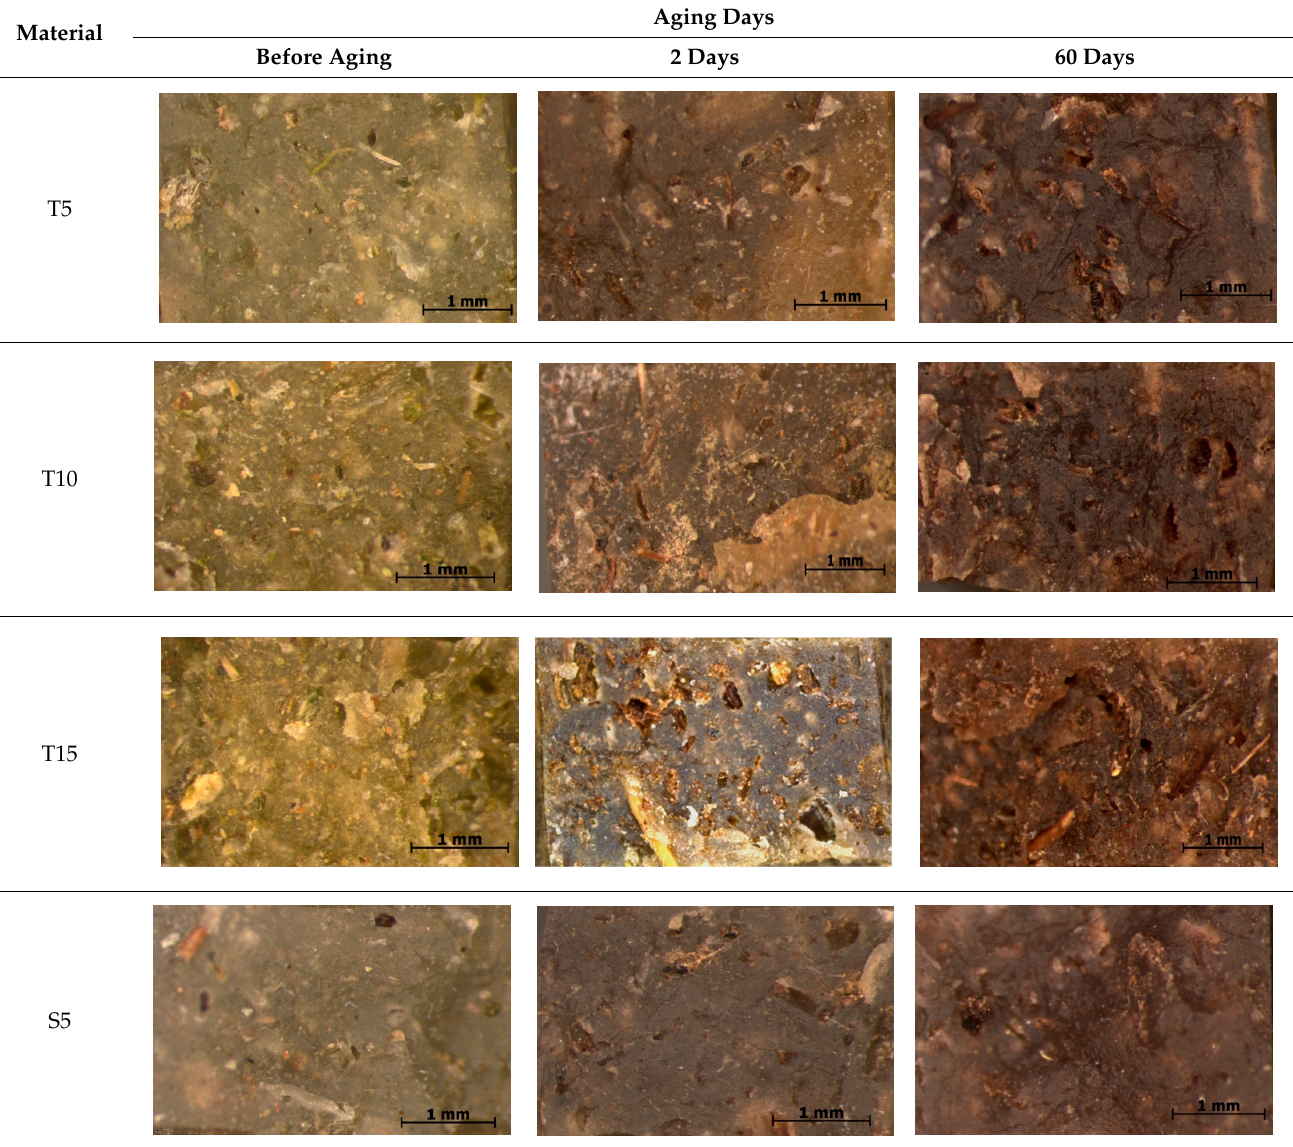
Table 5. Cross section of composites’ samples.